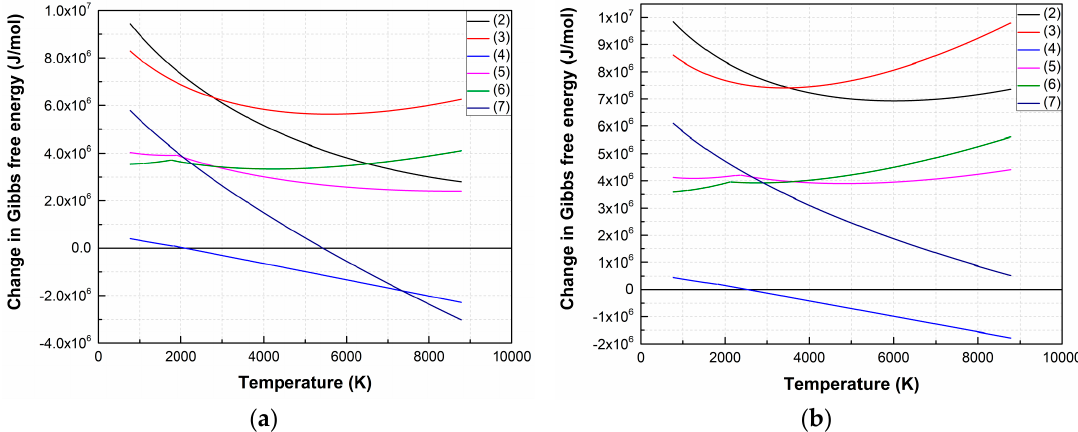
Figure 1. ∆ G temperature dependences of LiNbO 3 decomposition reactions in a vacuum (1 × 10 − 5 Torr) ( a ) and oxygen atmosphere (1 × 10 − 2 Torr) ( b